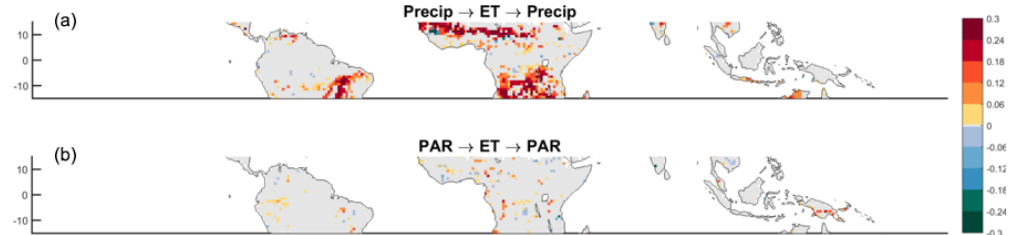
Figure 12. Land–atmosphere feedback strength (change in the variance due to the feedback) between precipitation (Precip) and ET (a) and photosynthetically active radiation (PAR) (b) based on recent metric developed by Green et al. (2017) using a multivariate Granger causality approach.